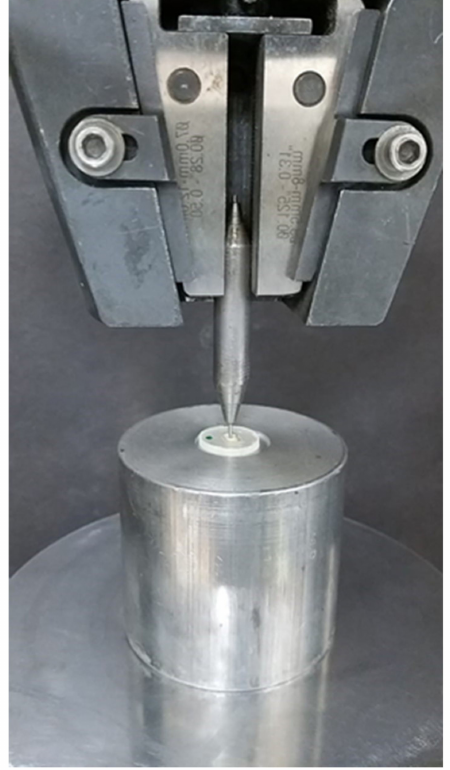
Figure 4. Push-out bond strength testing on universal testing